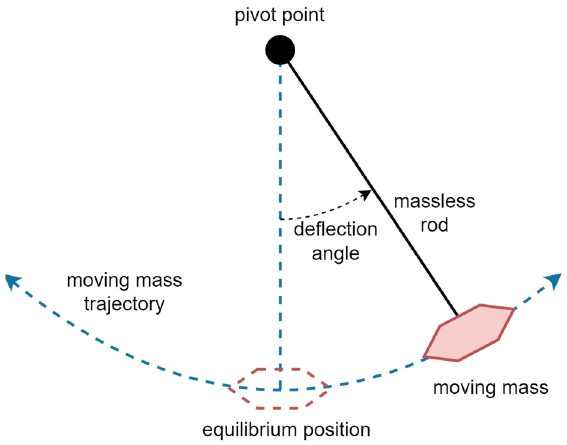
Figure 11. The ideal gravity pendulum [40].